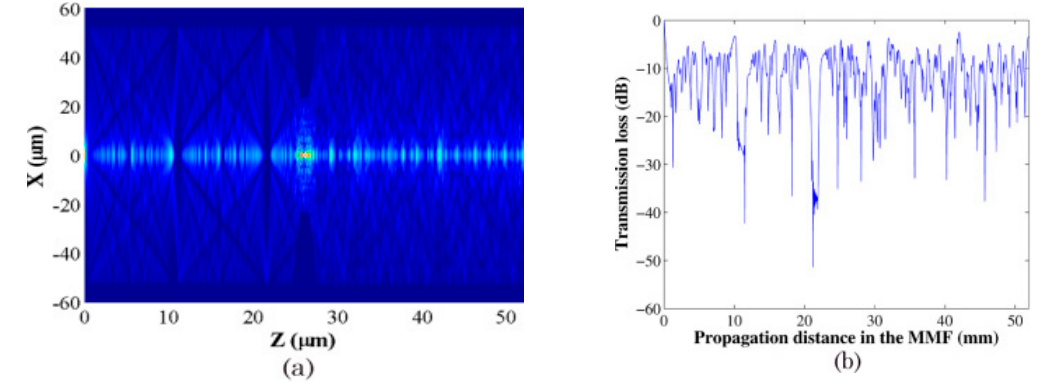
Figure 5. ( a ) Field distribution evolution; ( b ) coupling loss relationship along the STMS fiber structure [27]. Reproduced with permission from Pengfei Wang, Gilberto Brambilla, Ming Ding, Yuliya Semenova, Qiang Wu, Gerald Farrell, Investigation of Single-Mode–Multimode–Single-Mode